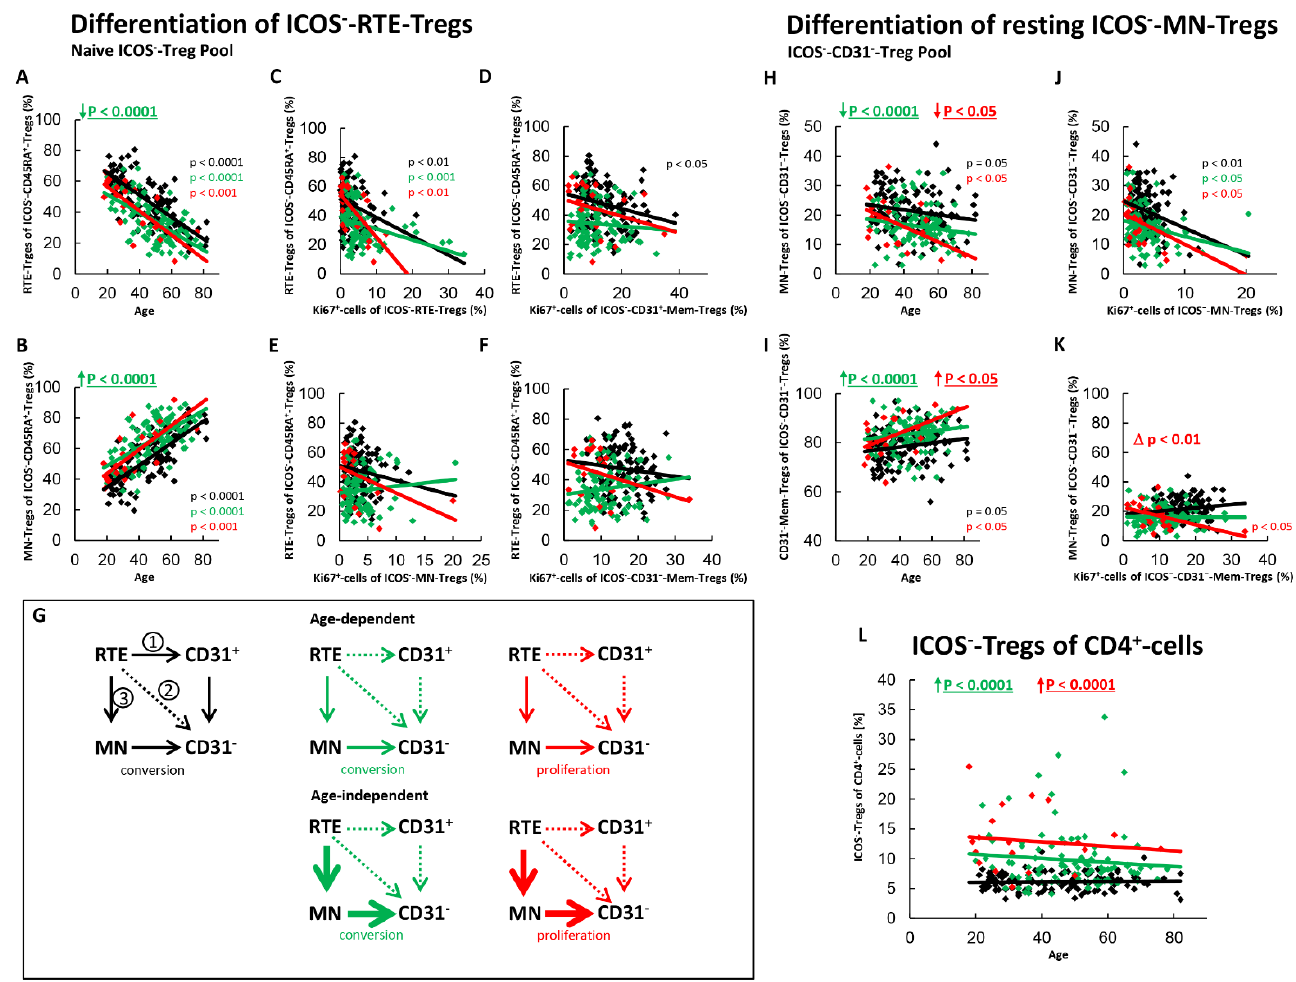
Figure 4. Differentiation of ICOS − -RTE-Tregs and resting ICOS − -MN-Tregs with age in healthy controls, SLE patients in remission and SLE patients with active disease. The percentages of RTE-Tregs and MN-Tregs within the naïve ICOS − -CD45RA + -Treg pool ( A , B ) as well as the percentages of MN-Tregs and CD31 − -memory Tregs within the ICOS − -CD31 − -Treg pool ( H , I ) were estimated depending on age, in healthy volunteers (Black coloured), SLE patients in remission (Green coloured) and SLE patients with active disease (Red coloured). In order to examine the differentiation of ICOS − -RTE-Tregs, the percentage of RTE-Tregs within total naïve CD45RA + -Tregs was correlated with the percentage of Ki67 + cells within total RTE-Tregs ( C ), CD31 + -memory-Tregs ( D ), MN-Tregs ( E ) and CD31 − -memory-Tregs ( F ). In order to examine the differentiation of resting MN-Tregs, the percentage of MN-Tregs within total CD31 − -Tregs was correlated with the percentage of Ki67 + cells within total MN-Tregs ( J ) and within total CD31 − -memory-Tregs ( K ). Significant linear regression analyses are marked by black, green, or red P-values. Significant differences in the regression lines between healthy controls and SLE patients in remission or active disease are marked by green or red ∆ p values. Age-independent significant differences between healthy volunteers and study groups are marked by an arrow ( ↑↓ ) and their color-matched P-values. The arrow diagrams ( G ) schematize an increased (thick arrow), consistent (thin arrow) or decreased (dashed arrow) differentiation, color matched for the different patient groups. The resulting age-dependent and age-independent changes in the percentage of ICOS − -Tregs within total CD4 + -T-helper cells are given in ( L ). Further information of the calculated P-values is illustrated in Table